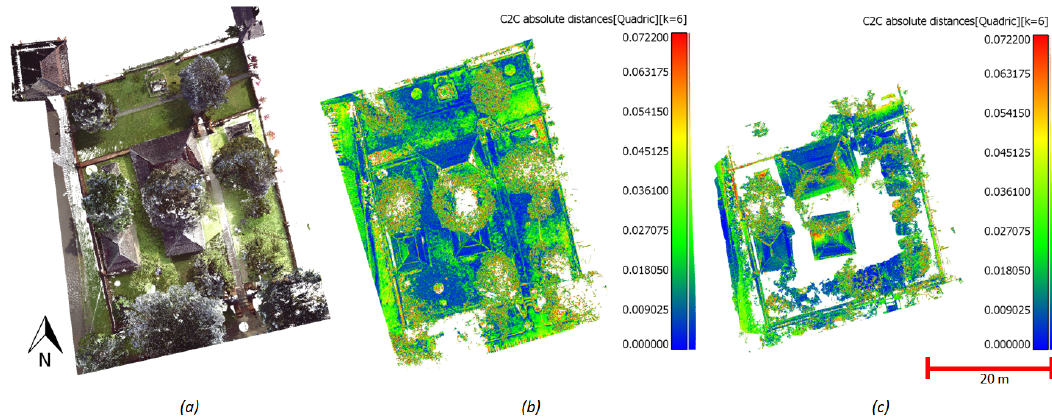
Figure 6. Results for the Siti Inggil area in Step 2. ( a ) shows the TLS point cloud. ( b ) shows the absolute distance between points from the TLS and UAV point clouds, with an average distance of 2.3 cm and a standard deviation value of 1.8 cm. ( c ) shows a similar analysis between TLS and terrestrial photogrammetry, yielding an average distance of 2.0 cm and a standard deviation of 1.6